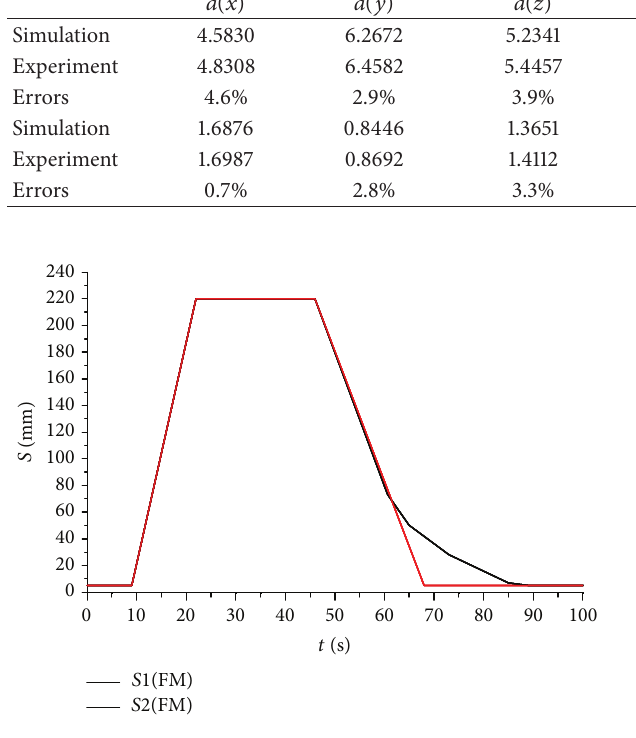
Figure 25: Displacement of